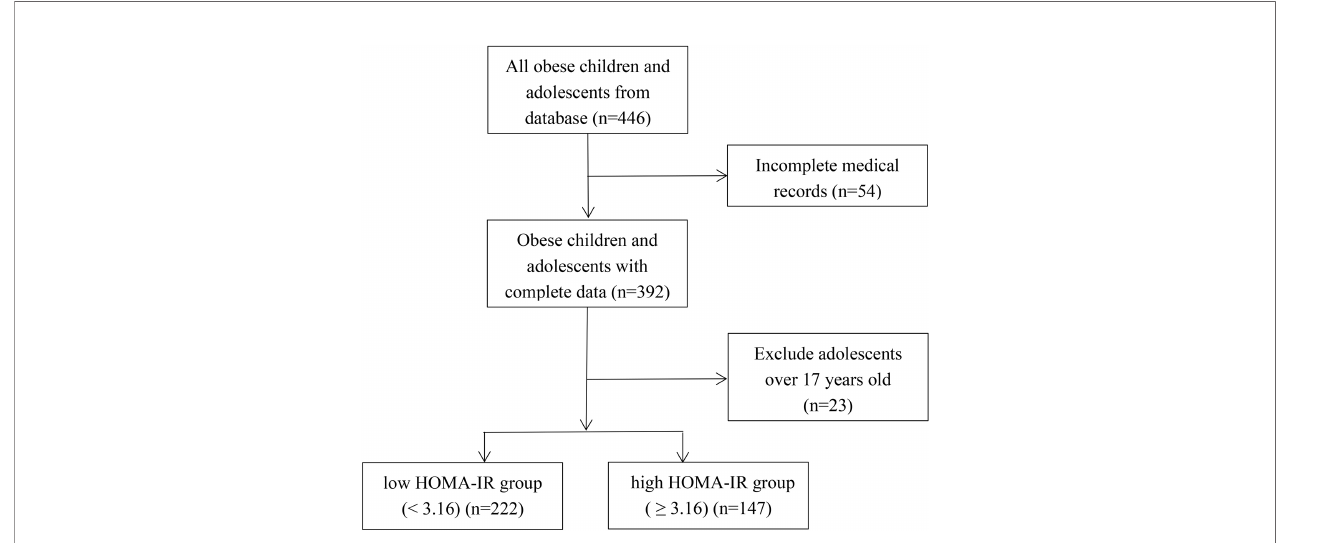
FIGURE 1 | Flowchart of collecting